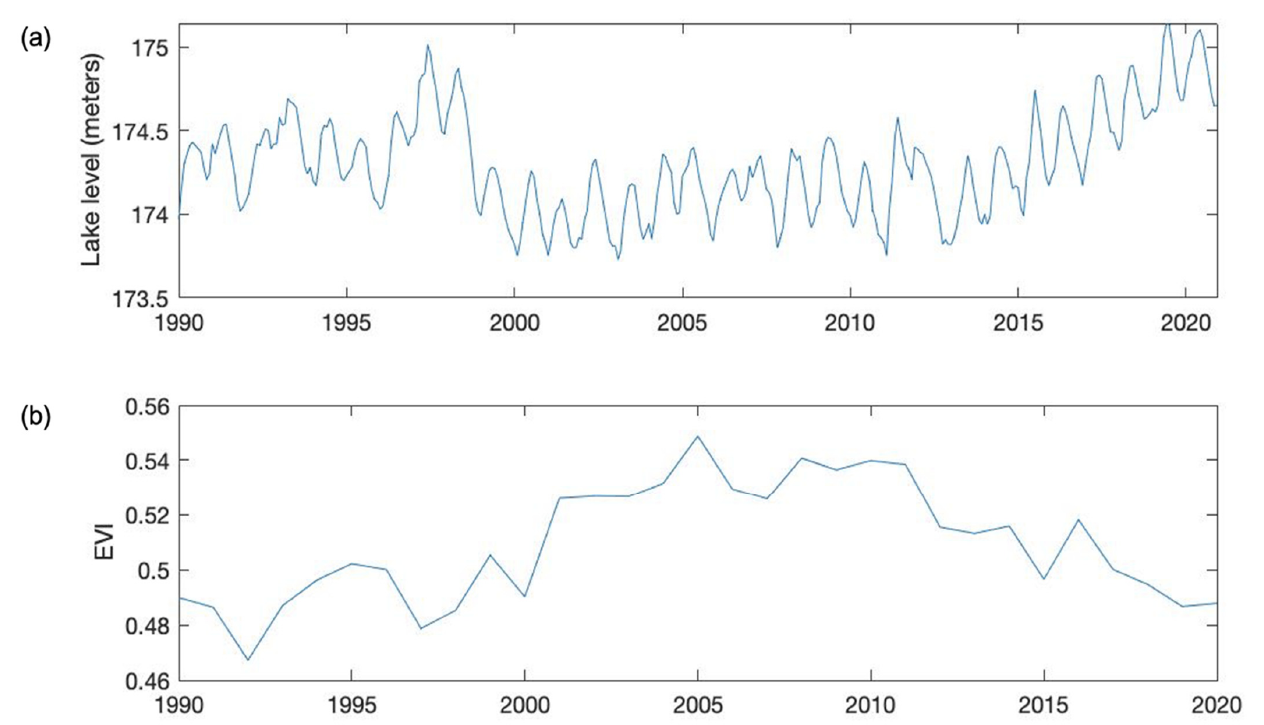
Figure 9. ( a ) Monthly mean lakeside average water levels from Toledo and Cleveland gauges (NOAA); ( b ) average max EVI for all phragmites and emergent wetlands of Lake Erie’s TAI. Our approach differs from those used in other ML studies of the Great Lakes region.